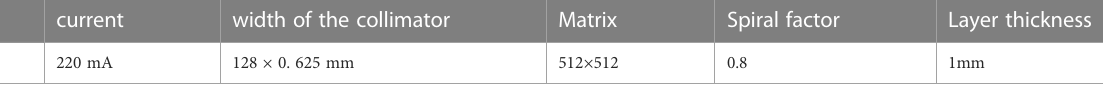
TABLE 1 CT Imaging Parameters.